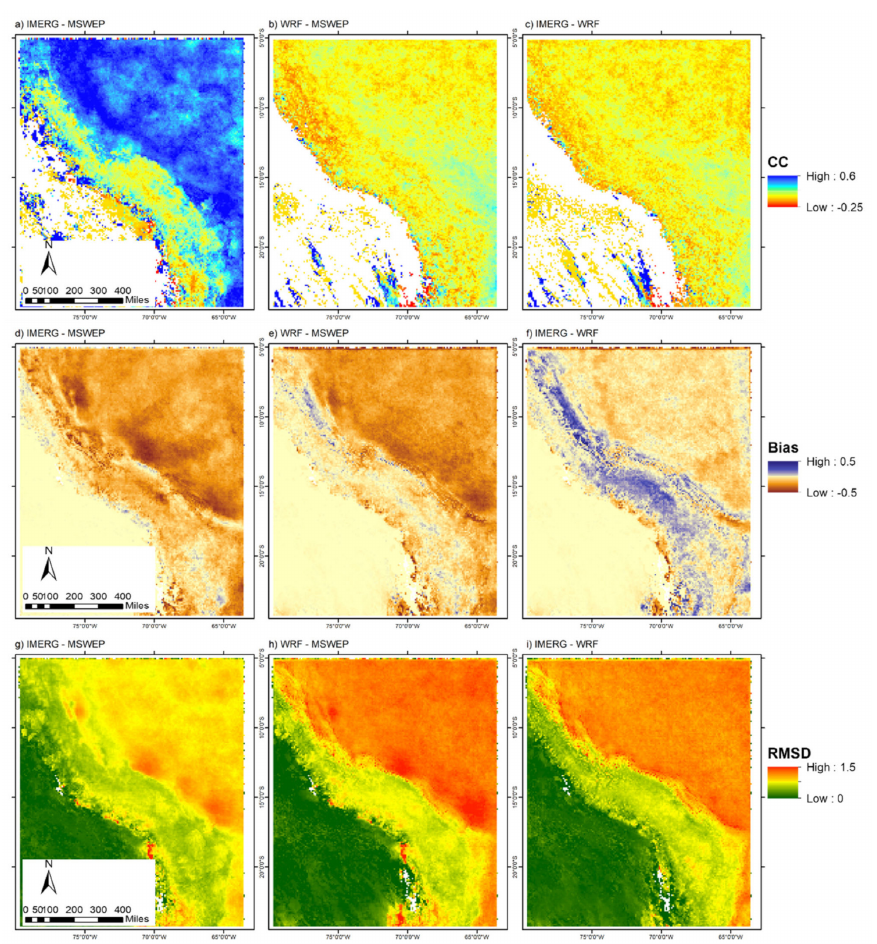
Figure 6. The cross examination of GPM IMERG, MSWEP, and WRF simulation at 6 h time steps from 2010 to 2019. The name on the right side of “-“ is the “reference data product” in the calculation. MSWEP product includes the GPM IMERG as one of the input datum [21];